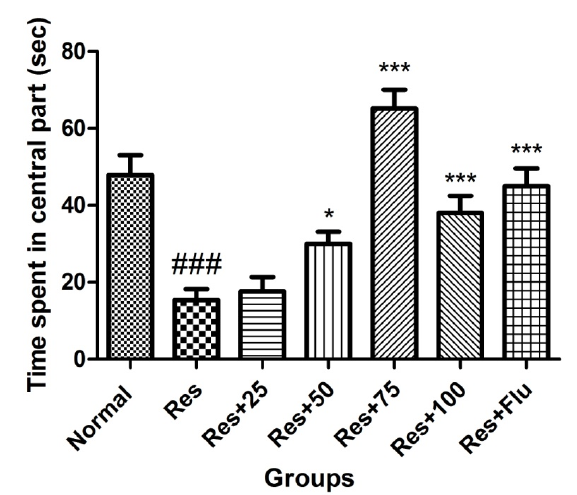
Figure 2. The effect of intraperitoneal injection of four different concentrations of Kelussia odoratissima Mozaffarian extract (25, 50, 75 and 100 mg/kg) on the time spent by mice in the central part. Flu= Fluoxetine, Res=reserpine. # Vs. normal group ( ### P < 0.001),